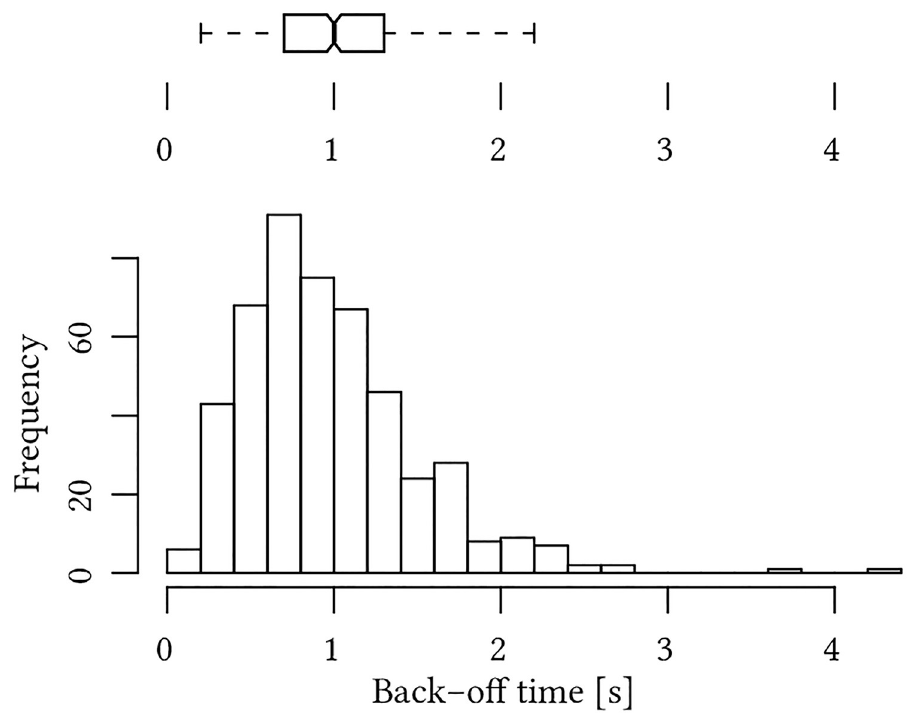
Fig 5. Histogram and boxplot of the back-off time. The cumulative number of designed back-offs is displayed in clusters with a width of 0.2 s back-off time. The boxplot displays median, quartiles, whiskers and 95% confidence intervals. The number of measurements is N =